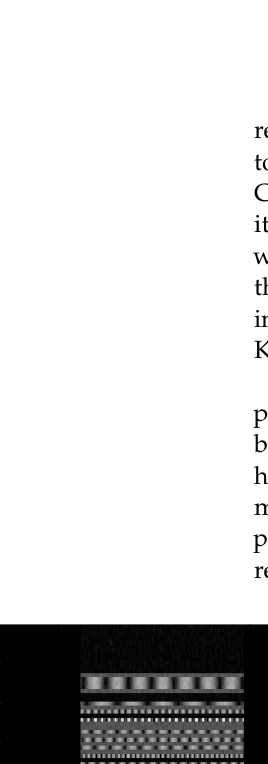
Figure 6. Images of the plane target at different iterations.